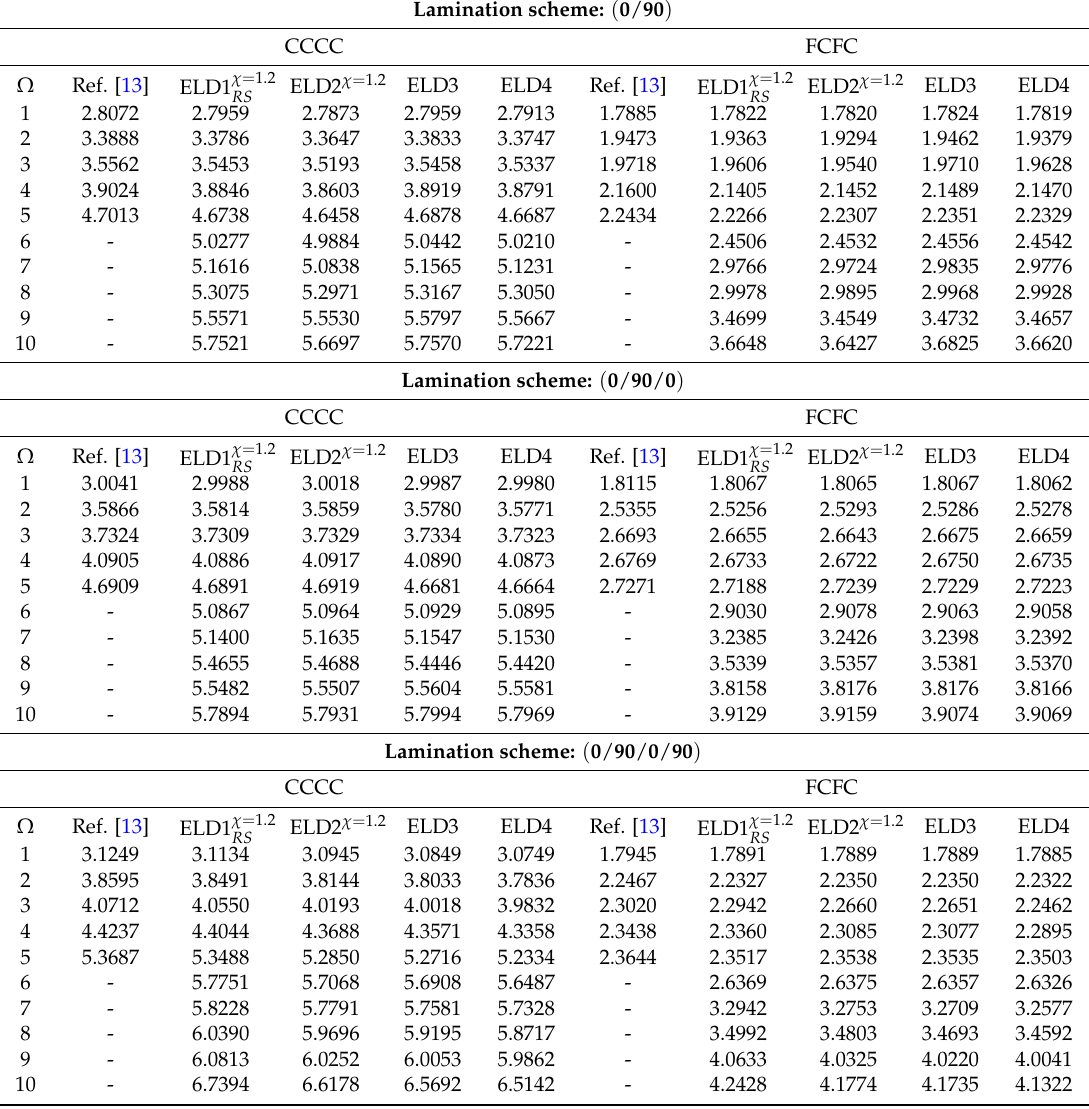
Table 6. Comparison of the frequency parameter Ω = 2 π f R toro-circular panel ( R b = − 1.5m) with different boundary conditions and lamination schemes. The ELW solutions are obtained by means of the GDQ method, using the Cheb-Gau-Lob grid distribution and assuming I N = I M =